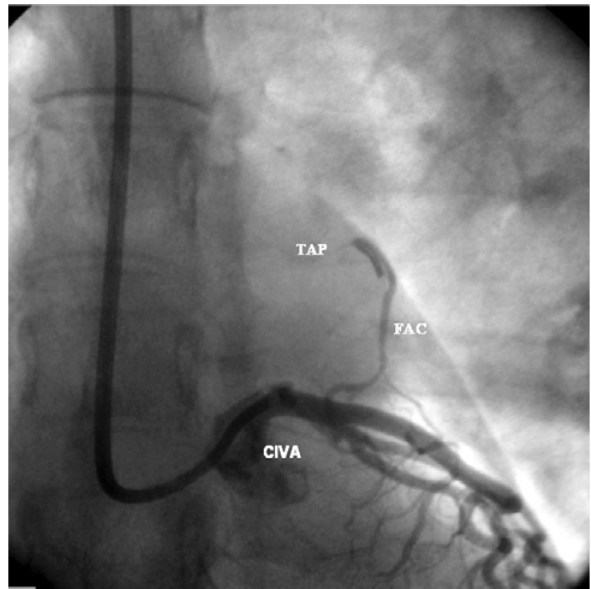
Fig. 1 - Angiocoronariografia mostrando fístula arterial coronária (FAC)